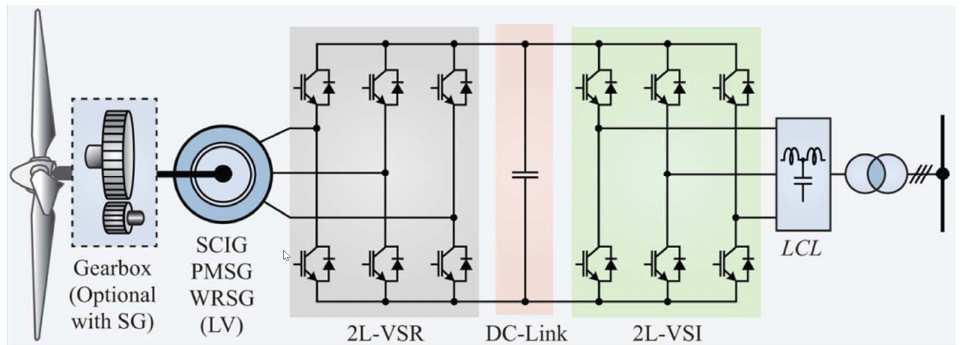
Figure 13. Grid-connected wind turbine system with a back-to-back (BTB) DC-link double-PWM voltage source converter (VSC).